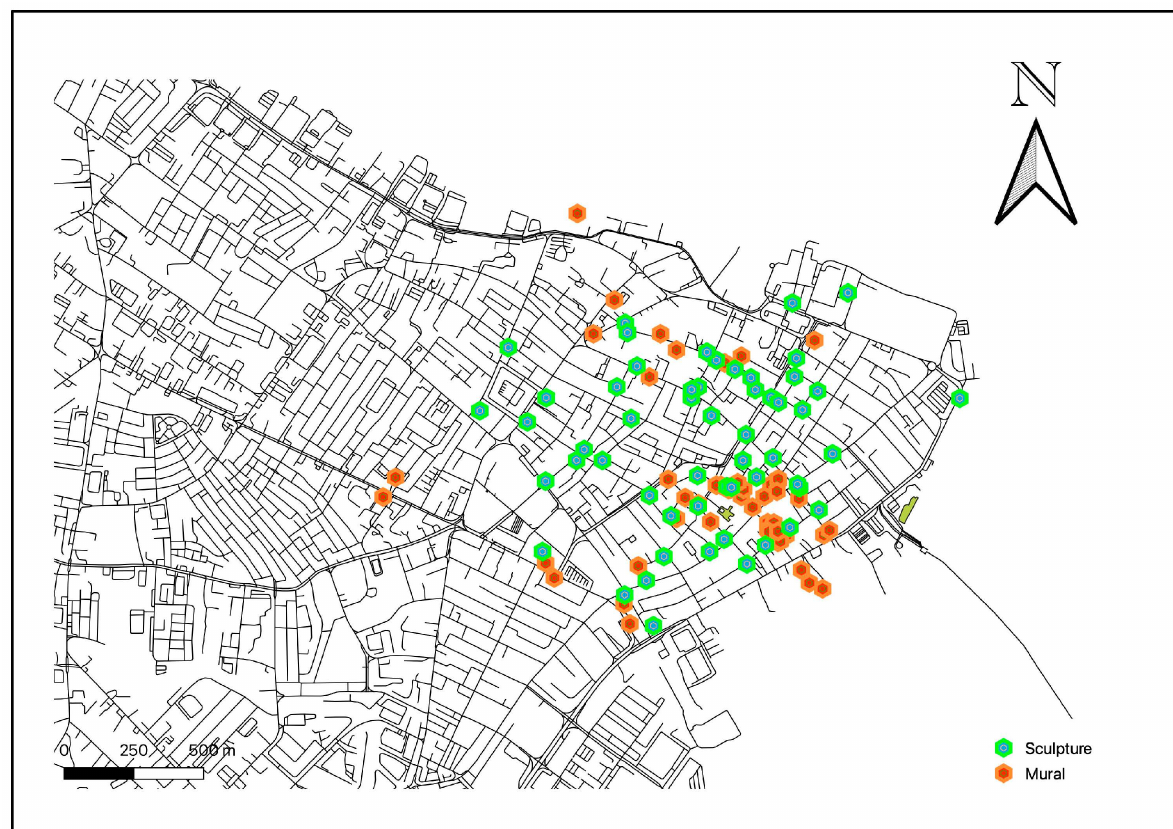
Figure 3. Locations of Sculptures and Murals in the George Town